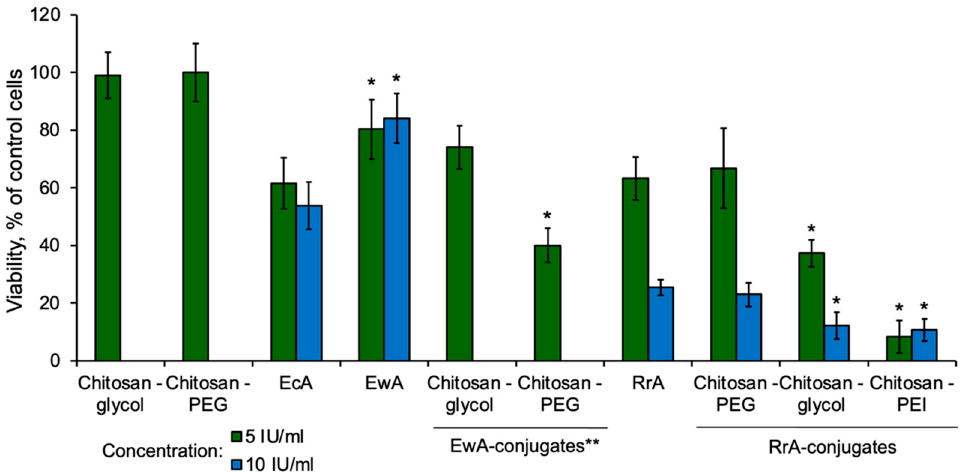
Figure 8. Cytotoxic activity of EwA, EcA, RrA, and EwA and RrA conjugates toward the K562 cell line. EcA, Escherichia coli L-ASNase; EwA, Erwinia carotovora L-ASNase; covalent conjugates EwA and RrA; PEG, polyethylene glycol; PEI, polyethyleneimine; RrA, Rhodospirillum rubrum . N = 4. * p ≤ 0.05 vs. cells treated with non-conjugated RrA. ** Data obtained earlier and published in the article [19].